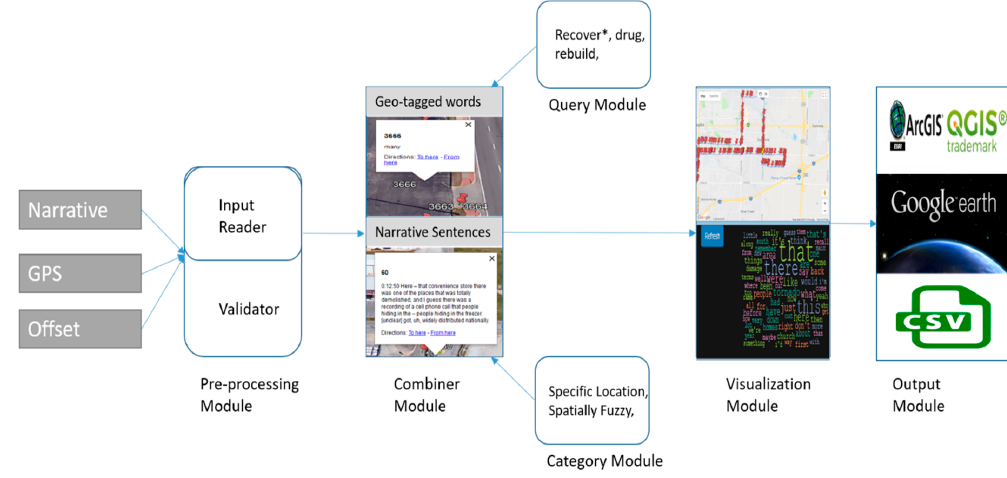
Figure 1. Conceptual diagram for Wordmapper with the six different modules.